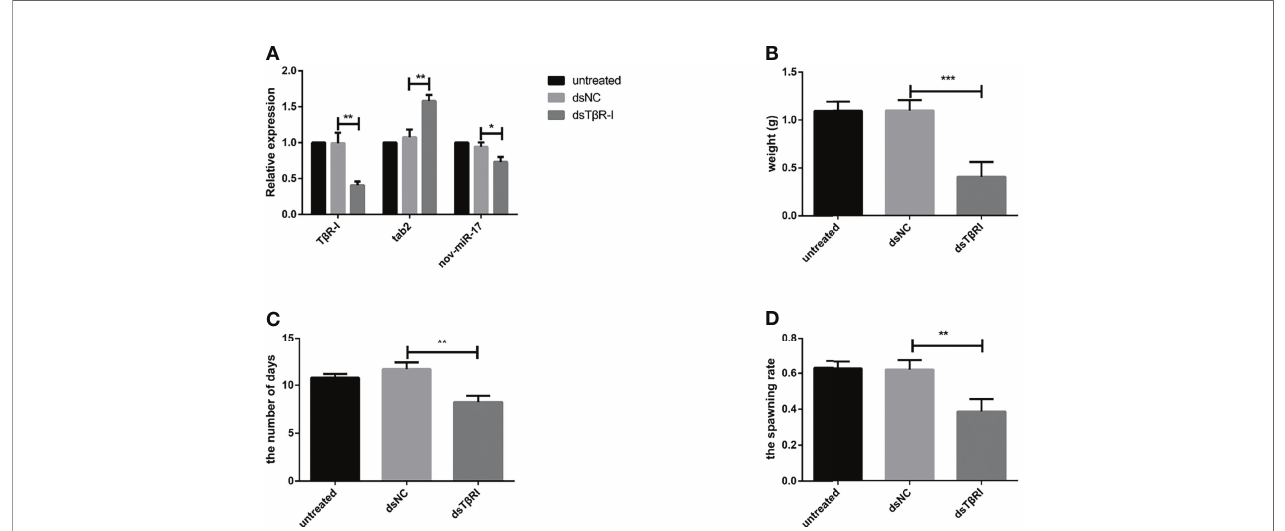
FIGURE 7 | (A) The expression of nov-miR-17, haa TAB2 and TGF-beta receptor type I (T b RI) in engorged ticks was tested after injection of dsT b RI by RT – qPCR. (B) Weight of fed ticks recorded in the dsT b RI experiment. (C) Number of days during which ticks were monitored in the dsT b RI experiment. (D) Spawn rate of the ticks in the dsT b RI experiment. The data are presented as the means ± SEMs of triplicate samples. * P < 0.05, ** P < 0.01, *** P < 0.001.